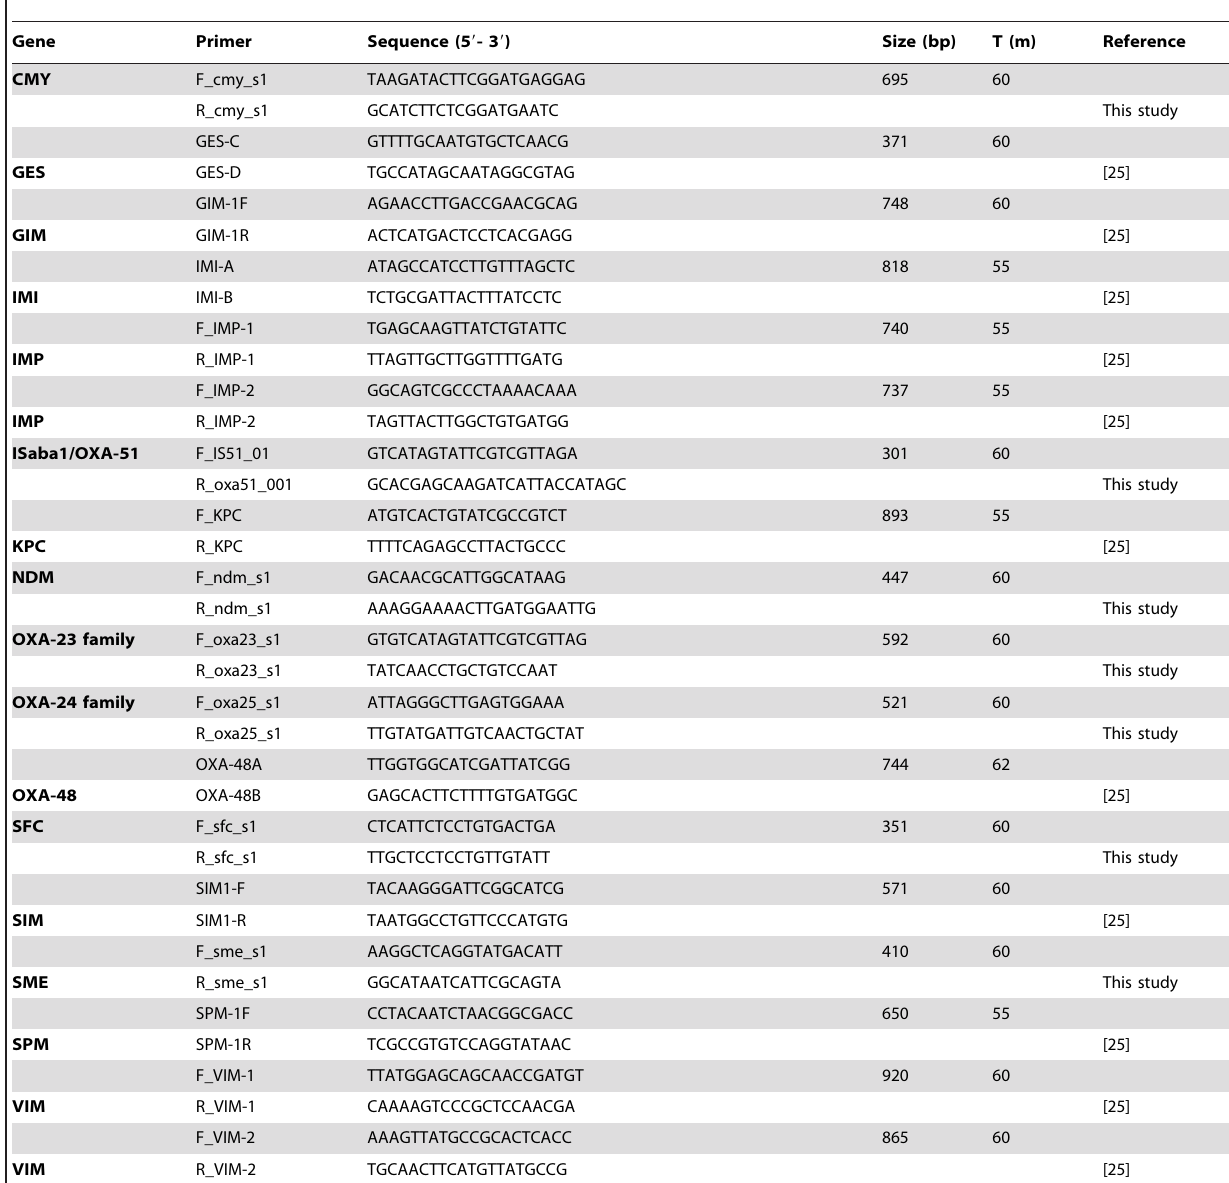
Table 4. Primers used for sequencing of resistance genes by polymerase chain reaction